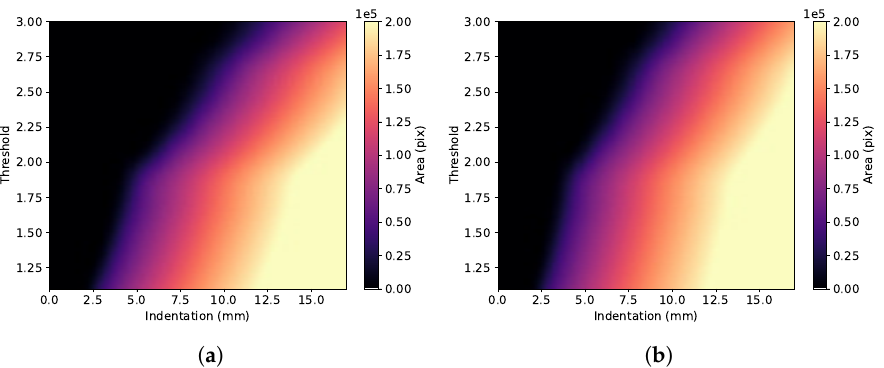
Figure 3. Changes in AOE thres with the threshold value and indentation value for ( a ) DF ( α = 5) and ( b ) VW ( C 2 = 5) material models The simulated tissue was converted from Cartesian to polar coordinates for efficient translation between clinical elastograms and simulated elastograms. The dimensions of each pixel are 0.023 ◦ and 0.008 mm. Figure 4 shows samples of the simulated proportional- increase field with traced outlines of AOE thres